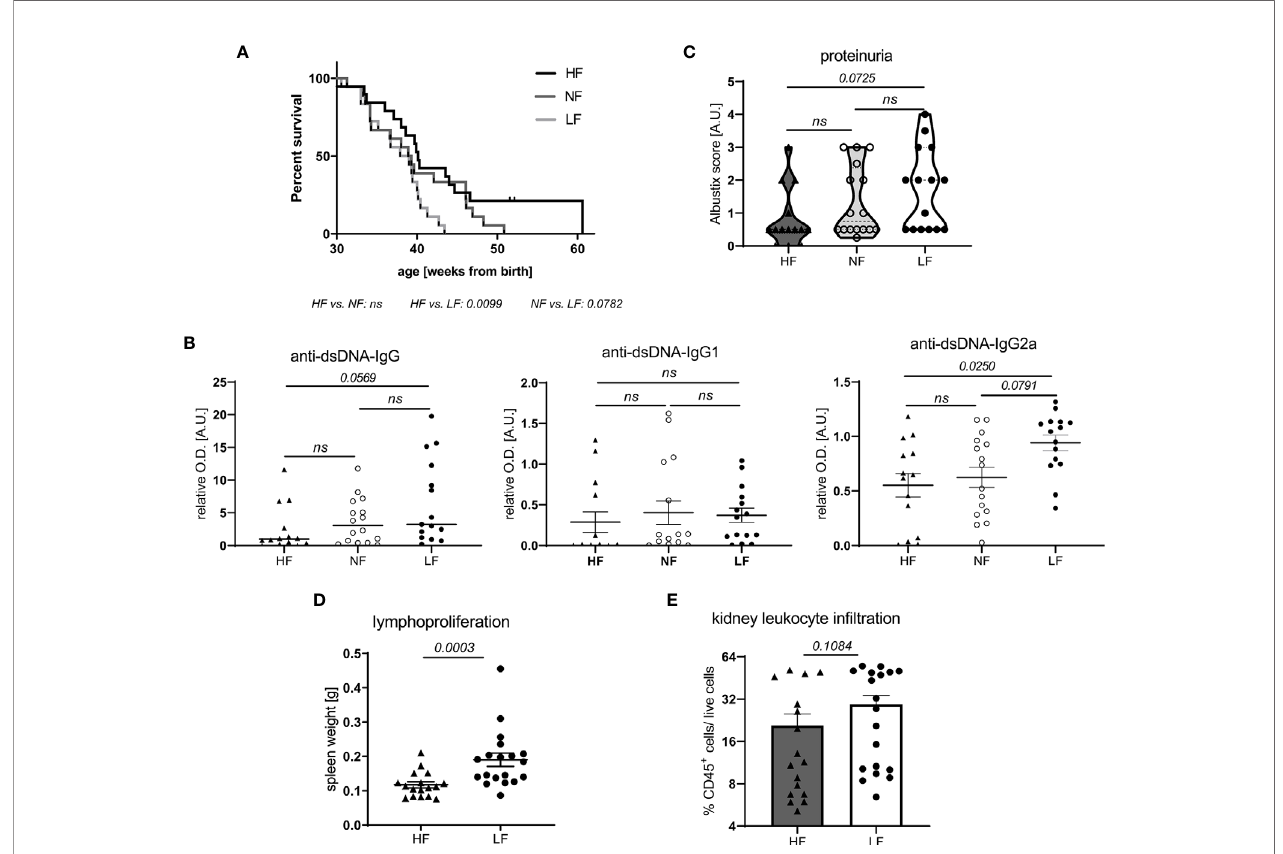
FIGURE 1 | Low intake of dietary fi ber accelerates disease in lupus-prone NZB/WF1 mice. (A) Overall survival (OS) determined in lupus-prone NZB/WF1 mice fed a high (HF; n = 19), normal (NF; n = 18) or low fi ber (LF; n = 18) diet. The Kaplan – Meier method was used for estimating OS in differently treated groups. (B – D) Determination of (B) total anti-dsDNA-IgG, -IgG1 and -IgG2a serum titers, (D) lymphoproliferation by spleen weight, (C, E) signs of beginning nephritis by kidney-in fi ltrating CD45 + leukocytes and proteinuria levels, in 28 w old animals fed a HF (n = 14 – 17 mice), NF (n = 16 mice) or LF (n = 15 – 19 mice) diet. Results are expressed as scatter blots with mean ± SEM; each data point represents an individual mouse; p < 0.05 was considered signi fi cant, p > 0.2 is indicated as ns, not signi fi